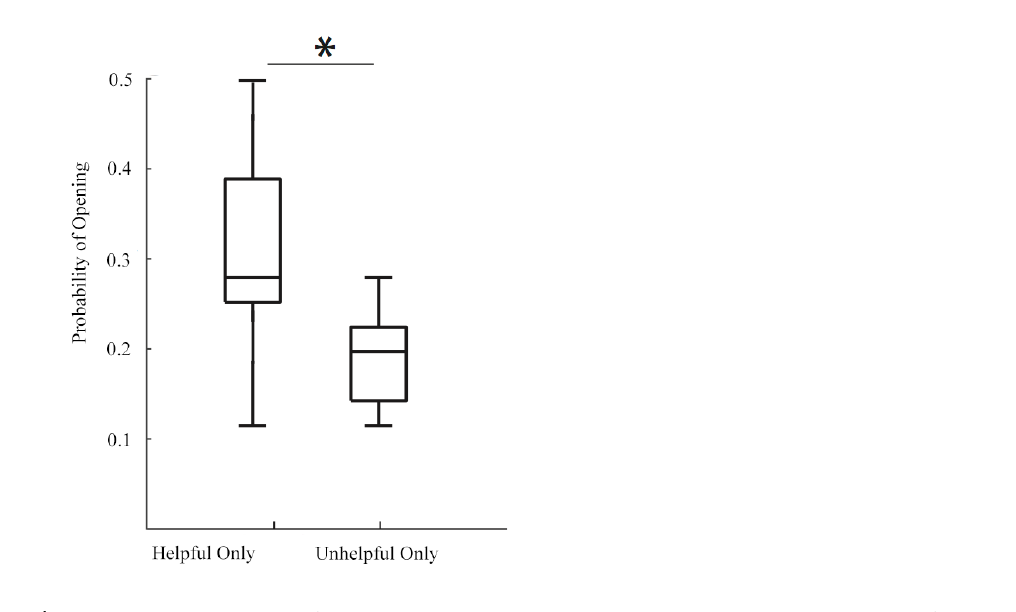
Figure 3 . When rats open only for one robot in a given trial, they are more likely to open the door for the helpful robot than the unhelpful robot. Center line = median. Top = 75 th percentile, bottom = 25 th percentile. * p < .05. Differences between sniffing times for the three odors were non-significant. (Friedman test p = .904). This is taken to indicate that the rats had no basic preference for any of the three odors tested (Figure 4).